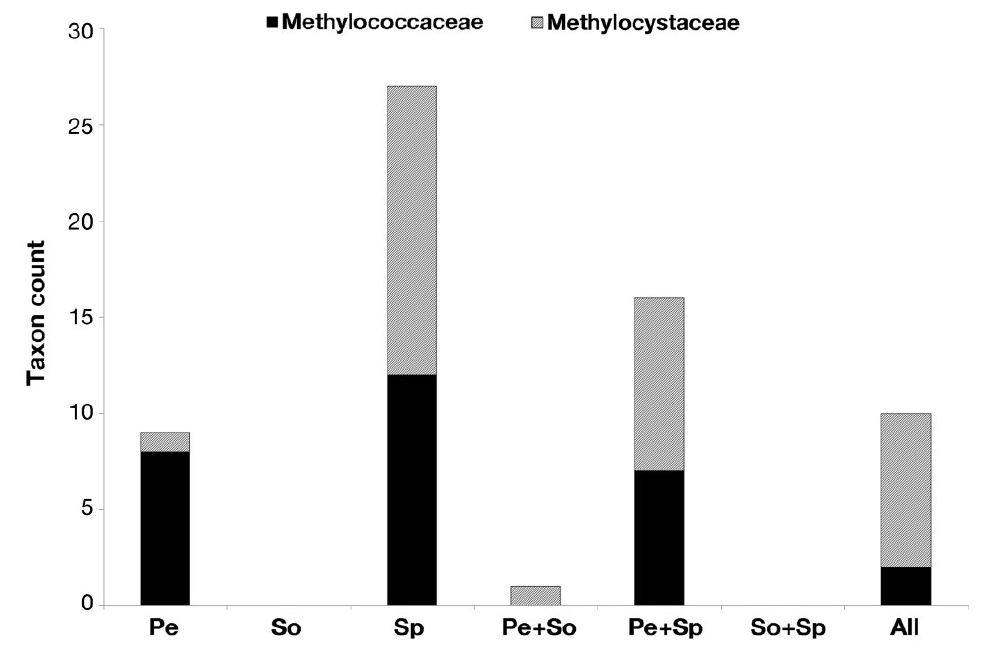
Figure 4. Graph of methanotroph 16S rRNA sequences related to the Methylococcaceae and Methylocystaceae and the habitats where they occurred. OTUs which only occurred (i) singly in one habitat only (peat, forest soil, and Sphagnum moss); (ii) in 2 habitats only (peat + forest soil, Peat + Sphagnum moss, and forest soil + Sphagnum moss) or (iii) across all three habitats. Most of these methanotrophs (~57% of the OTUs) detected in surface peat, forest soil and Sphagnum moss are unique and are not detected in another habitat. In contrast, only a small proportion of these methanotrophs (~15% of the OTUs) co-occur in all three habitats. Pe, peat; So, forest soil; Sp, Sphagnum moss; All, all